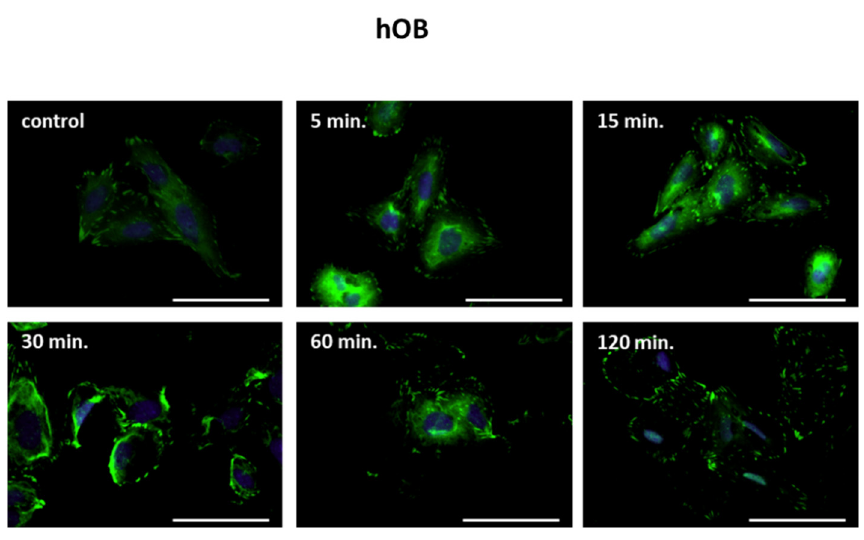
Figure 7. Exogenous Sema3A does not lead to alterations of the focal contacts in osteoblasts of the alveolar bone. Human primary osteoblasts of the alveolar bone were stimulated with recombinant Sema 3A [100 ng/mL] for the periods indicated. The detection of vinculin by immunofluorescence did not reveal any Sema3A-dependent dissolution of focal contacts. Scale = 20 µm.